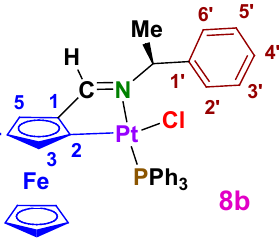
Figure A5. Atom labelling scheme for compound 8b .